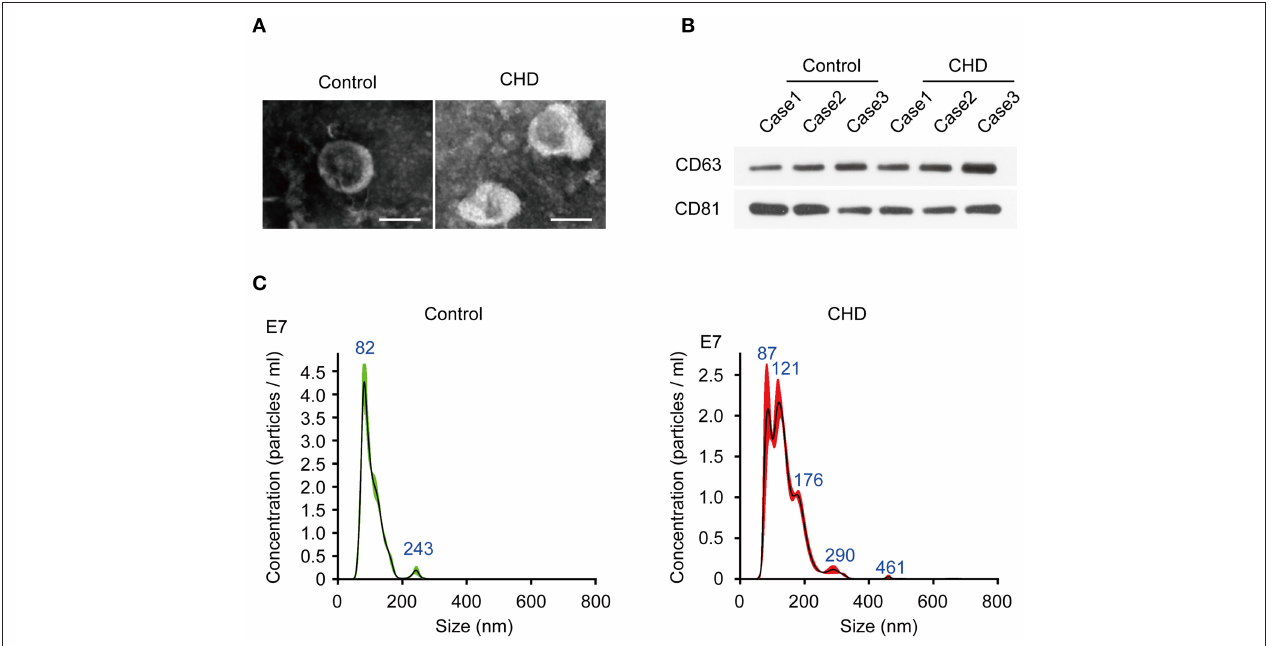
FIGURE 1 | Identification of plasma exosomes in CHD patients. (A) The representative images of plasma exosomes derived from CHD group and the control group patients analyzed by transmission electron microscopy. Scale bar, 100nm. (B) The positive markers of exosomes, CD63 and CD81 were detected in of plasma exosomes by Western blot. (C) Nanosight particle tracking analysis (NTA) of plasma exosomes derived from CHD group and the control group